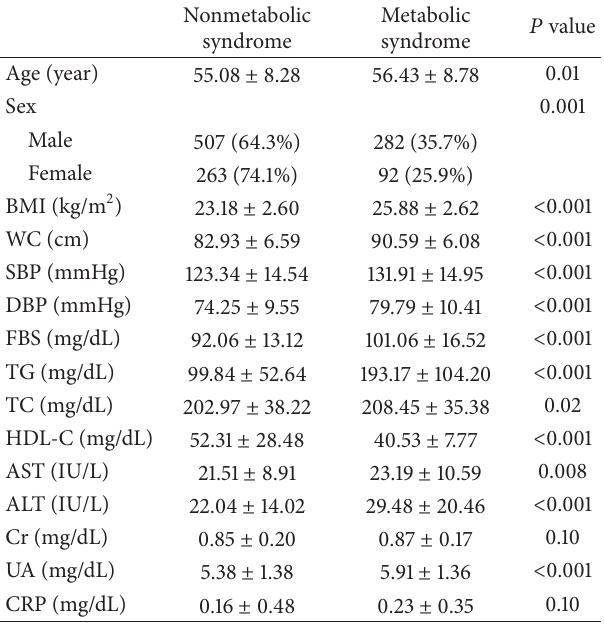
Table 1: Clinical characteristics of subjects without and with metabolic syndrome.